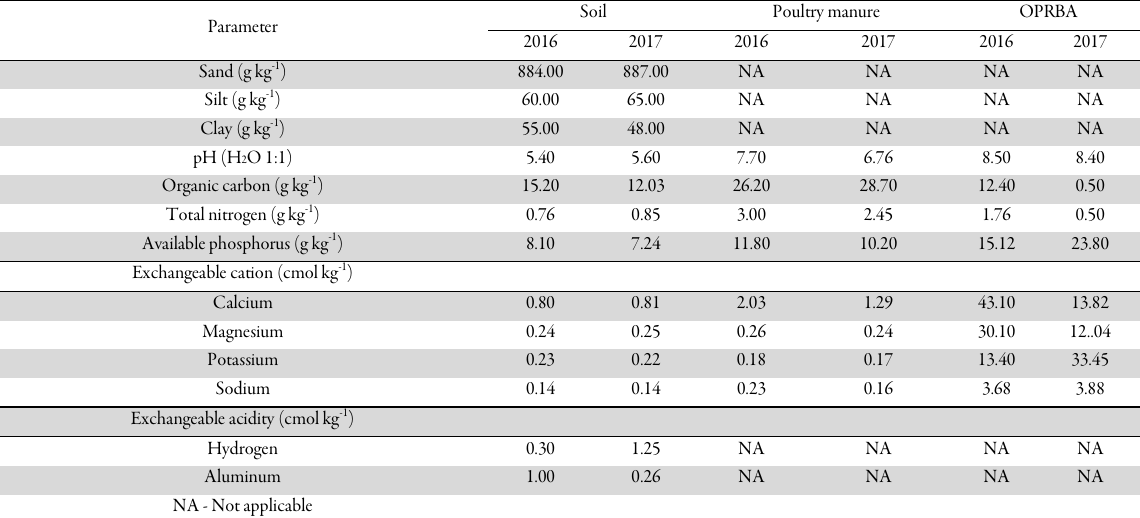
Table 1. The physical and chemical properties of the soil of the experimental site prior to cropping and the chemical composition of poultry manure and oil palm refuse ash Soil Poultry Parameter